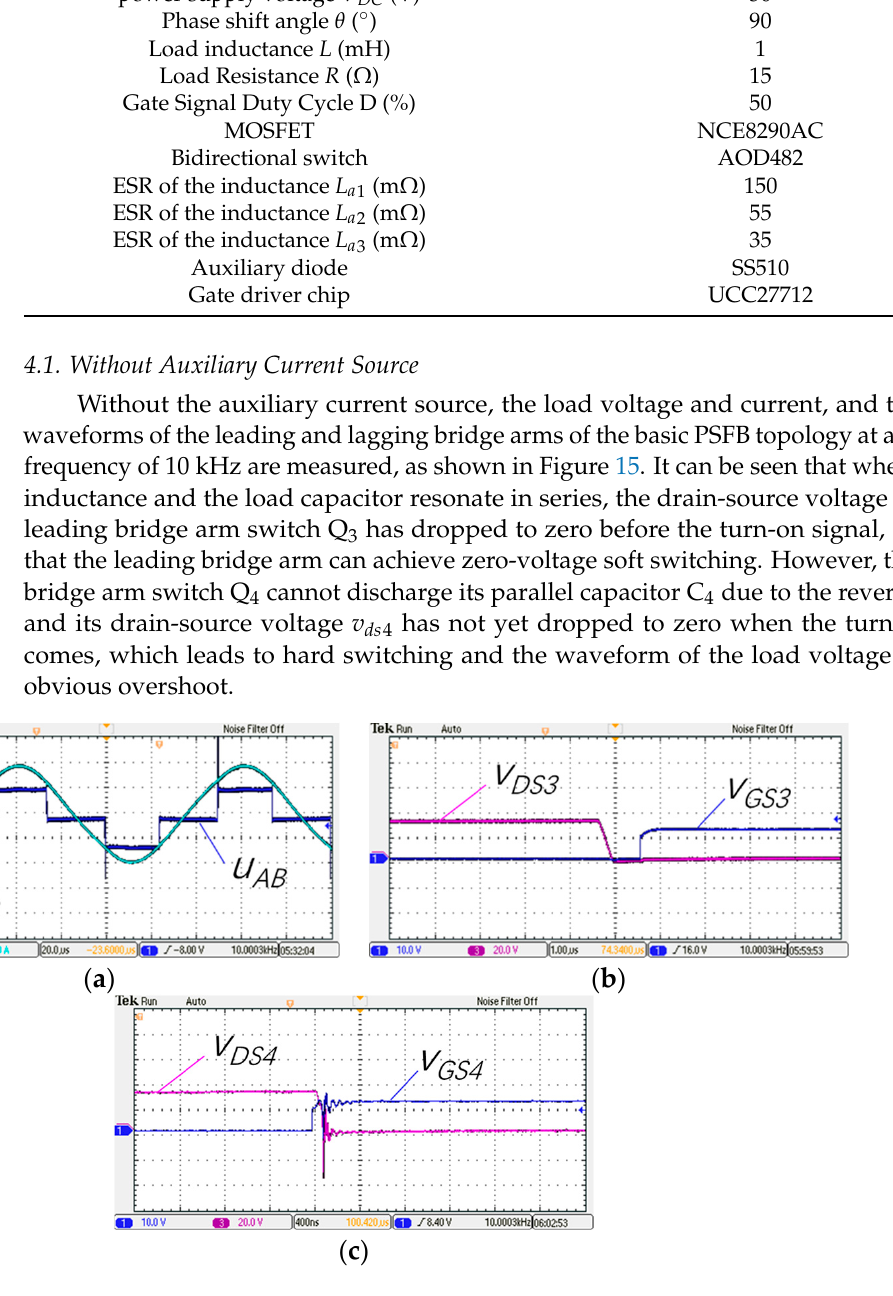
Figure 15. The relevant waveforms without auxiliary current source. ( a ) Load voltage and current waveforms; ( b ) Q 3 trigger signal and Q 3 drain-source voltage waveform; ( c ) Q 4 trigger signal and Q 4 drain-source voltage waveform.